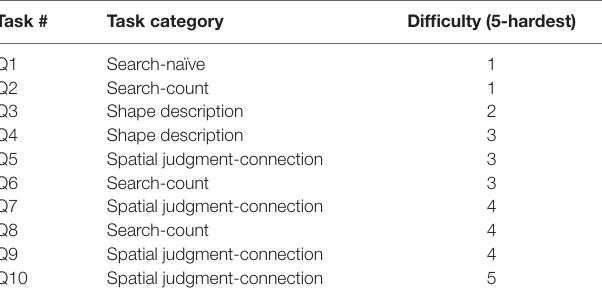
TaBle 1 | Tasks with abstract categories and difficulty